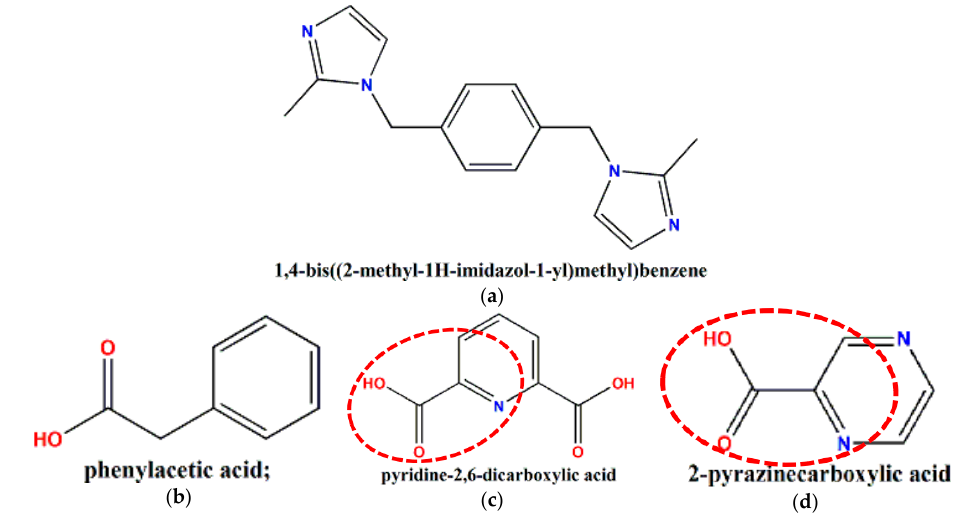
Figure 3. The structure of compound 3 : ( a ) coordination environment of the Cu(II) ion (symmetry transformations used to generate equivalent atoms: 1 1 + X, +Y, +Z; 2 − X, − Y, − Z; 3 − 1 + X, +Y, +Z ),